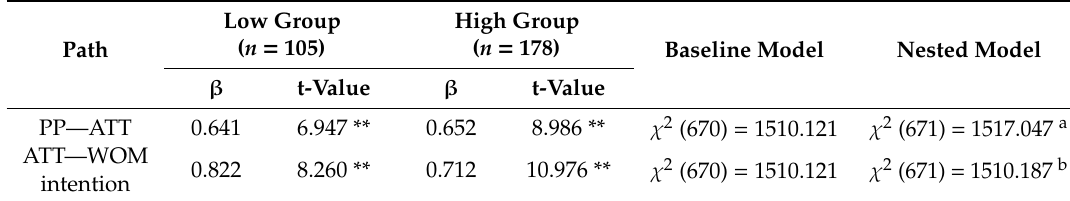
Table 4. Results for the moderating role of